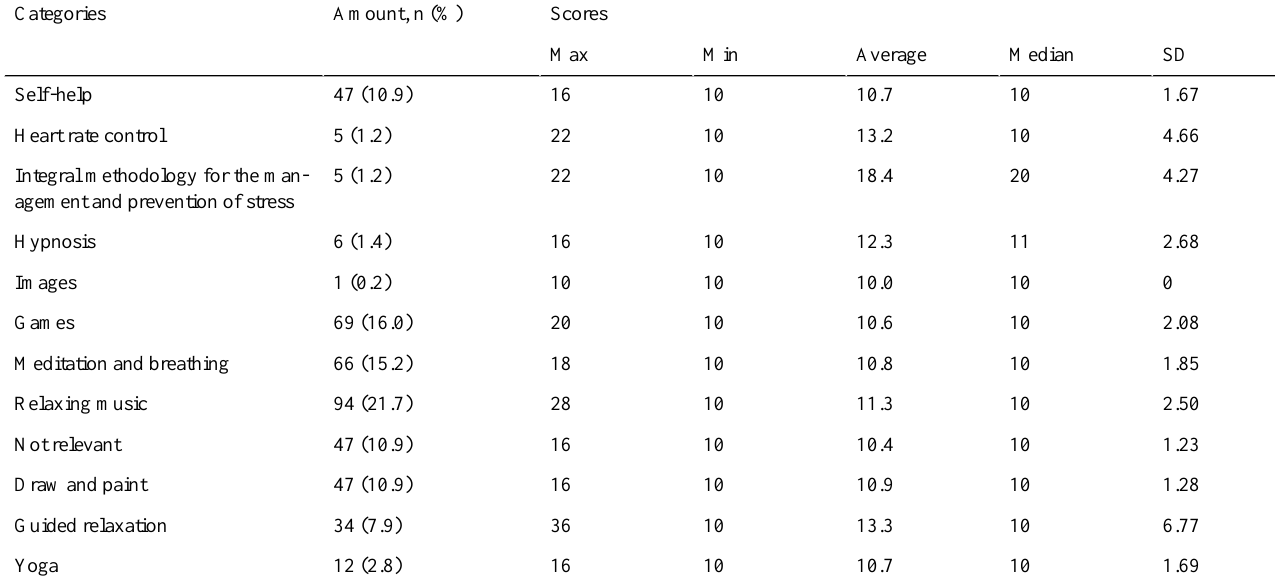
Table 1. Mobile app categorization statistics (n=433).